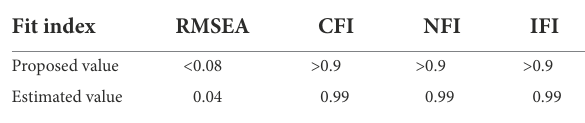
TABLE 2 Model fit